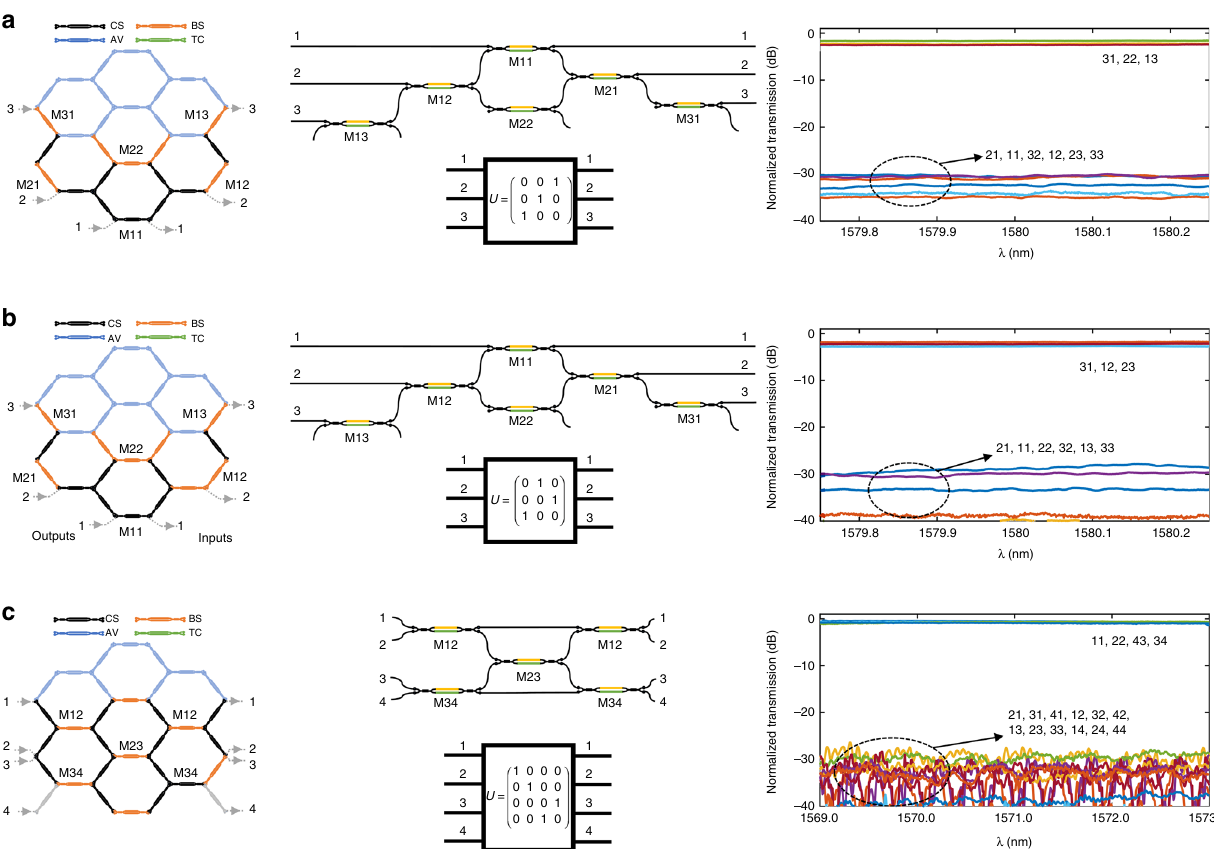
Fig. 6 Experimental results for multiple input multiple output linear optic transformation devices. Waveguide mesh connection diagram, circuit layout, and measured modulus transfer function for a a 3 × 3 column swapper between inputs 1 and 3; b 3 × 3 backward input swapper; c C-NOT gate. For each case, the fi rst column shows the 7-cell hexagonal waveguide mesh con fi guration, where each Mach Zehnder Interferometer (MZI) device is represented by a given color depending on whether it is activated as a cross ( black ) or bar ( orange ) switch, a tuneable coupler ( green ) or not used/available ( blue ). The second column shows the layout of the implemented structure, while the third column shows the spectral measurement (modulus) of all input/output port connections labeled by XY , where X and Y represent the output and input port numbers, respectively. CS, cross state; BS, bar state, AV, available,